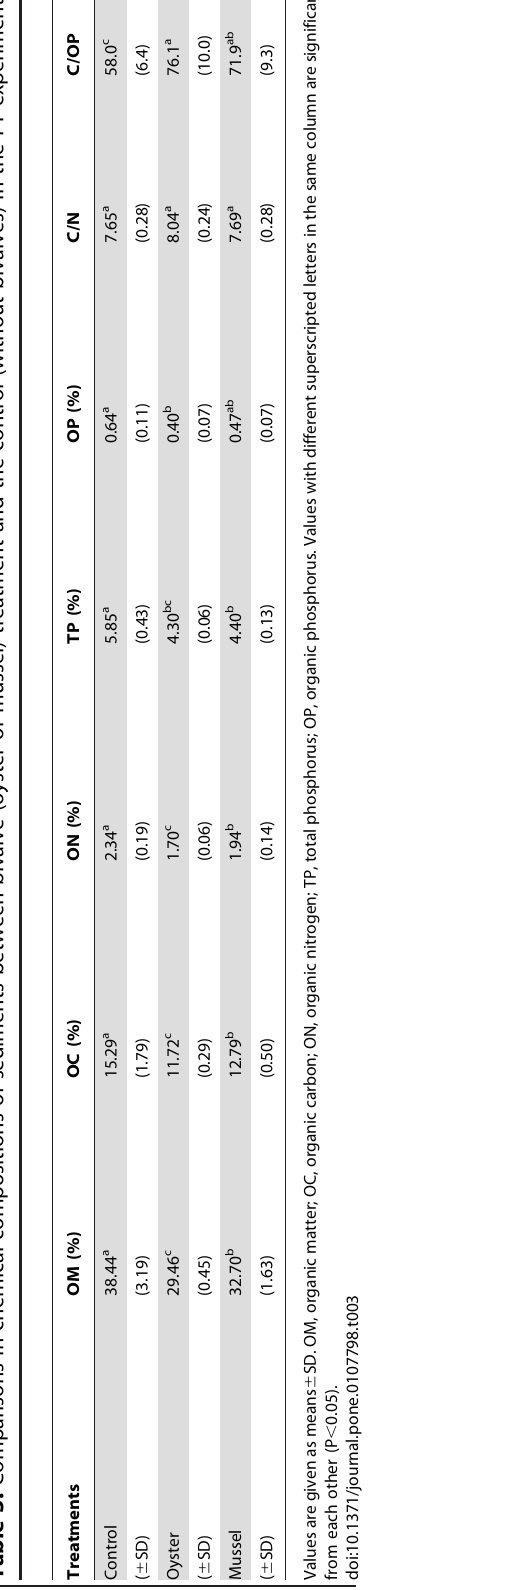
Table 2) in this